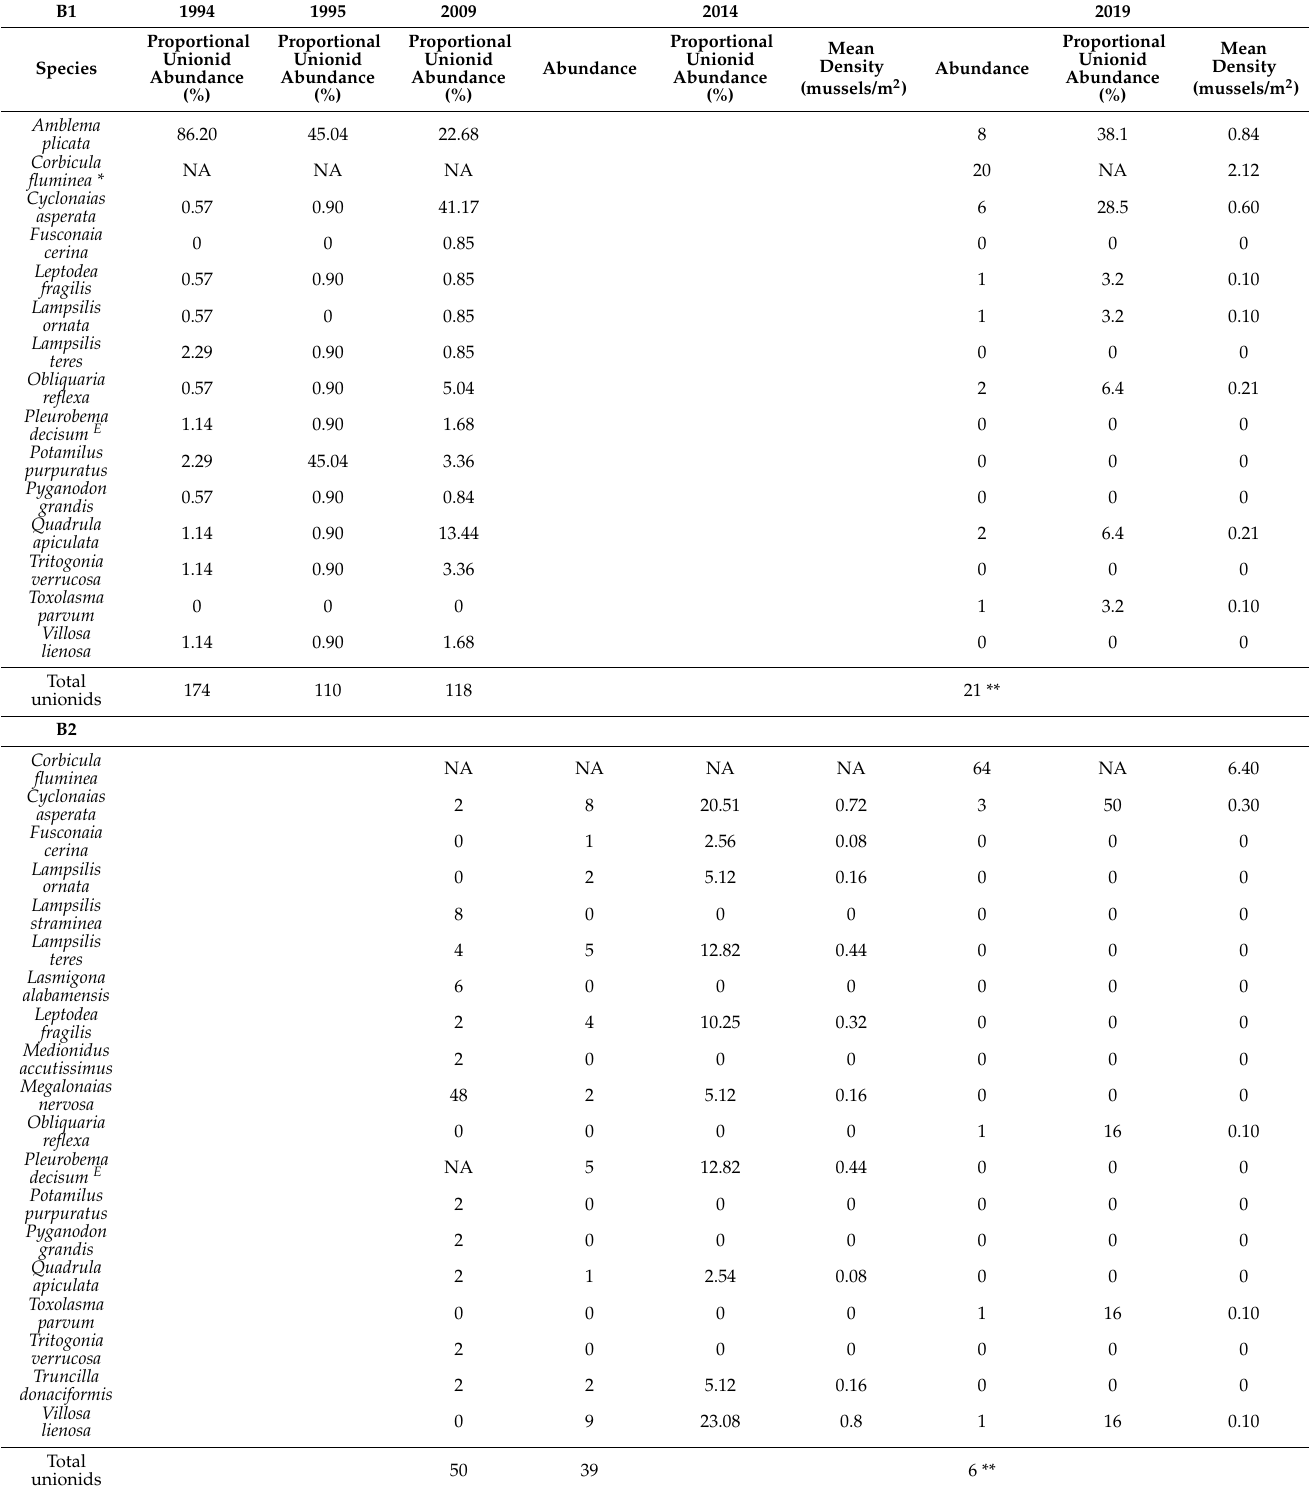
Table 3. Proportional abundance of mussel species from qualitative surveys performed in 1994, 1995 and 2009 and mean densities and total abundance from quantitative surveys performed in 2014 and 2019 for two sites in Bogue Chitto Creek. Species conservation status is indicated by superscripted letter following name (Alabama Department of Wildlife and Fisheries). * C. fluminea not computed for relative unionid abundance. ** Indicates that additional qualitative surveys were performed (Table S3). E Indicates that the species is federally